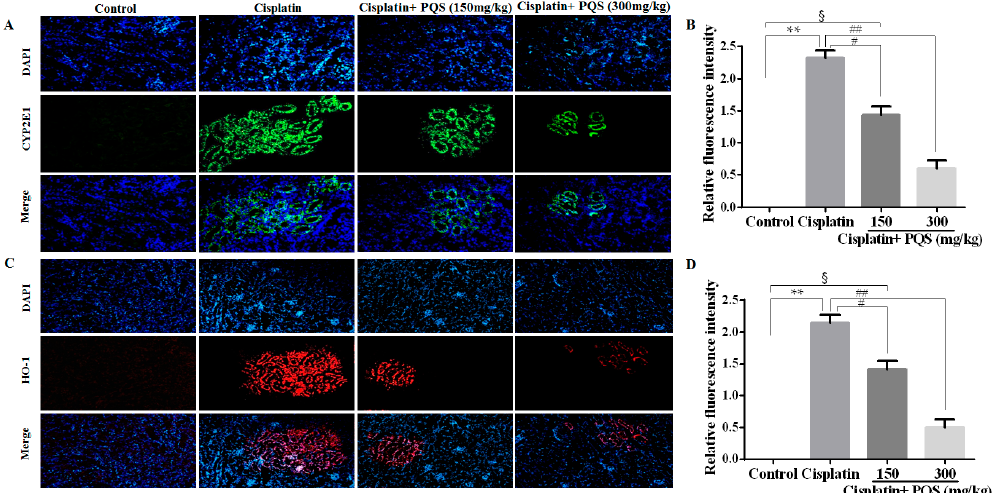
Figure 3. Effects of PQS on the expression of: enzyme cytochrome P450 E1 (CYP2E1) ( A ); and heme oxygenase-1 (HO-1) ( C ). The expression level of CYP2E1 (Green) and HO-1 (Red) in tissue section isolated from different groups was assessed by immunofluorescence. Column chart ( C , D ) shows relative fluorescence intensity. Representative immunofluorescence images were taken at 400×. 4 ′ ,6-Diamidino-2-phenylindole (DAPI) (Blue) was used as a nuclear counterstain. § p < 0.05, ** p < 0.01 vs. control group; # p < 0.05, ## p < 0.01 vs. cisplatin group.